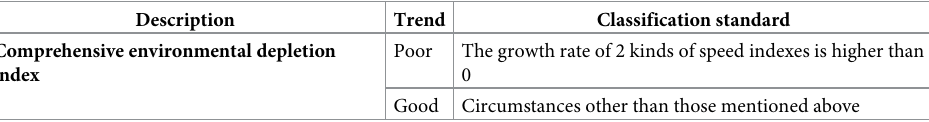
Table 2. Classification standard of comprehensive environmental depletion